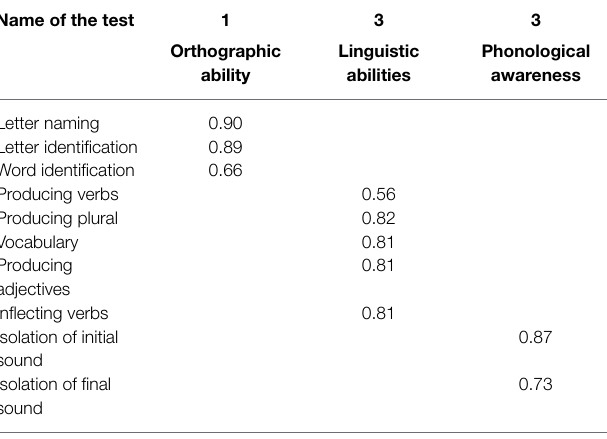
TABLE 1 | Loadings and factor division findings for the different literacy tests.